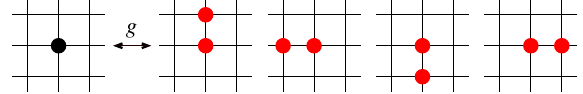
FIG. 17. Illustration of the mixing process between the magnon (black circle) and the spinon pair (red circles). With mixing strength g , a magnon on a given sublattice splits up into a spinon pair occupying nearest-neighbor sites. The spinon pair can recombine and form a magnon on the original